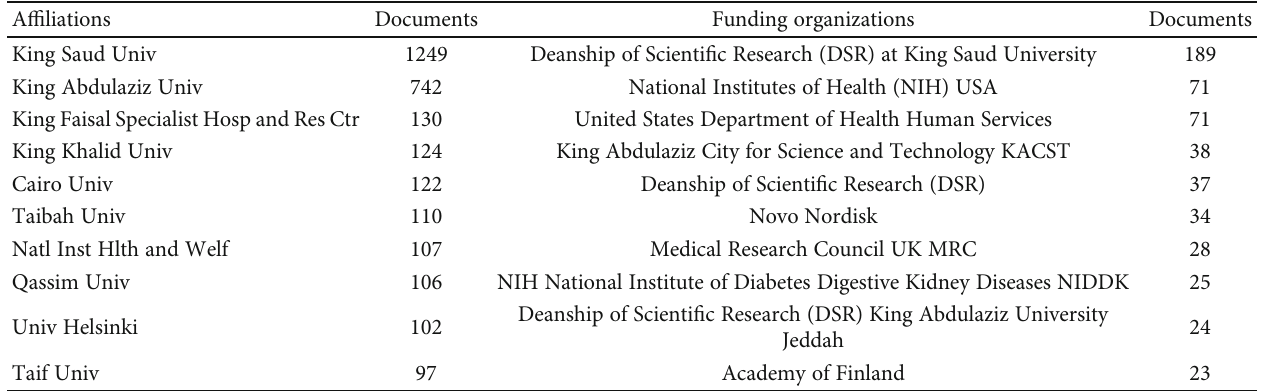
Figure 2: Three- fi eld plot for the top 20 most productive country, author, and organization. Table 3: Top 10 most frequent a ffi liations and funding